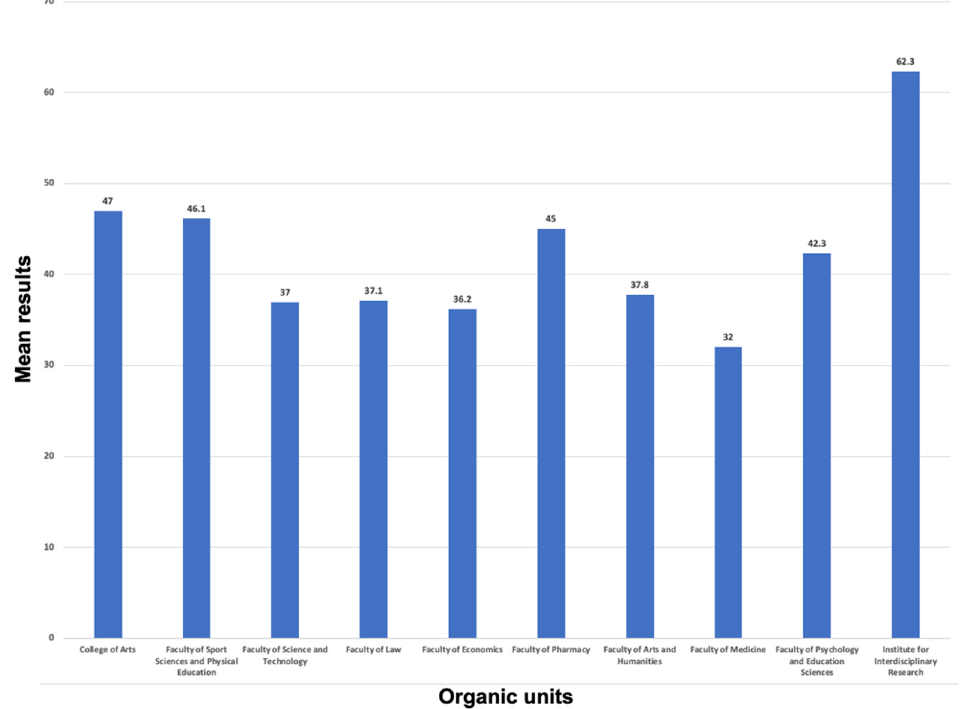
Figure 7. Mean results by Faculty and Organic Unit.